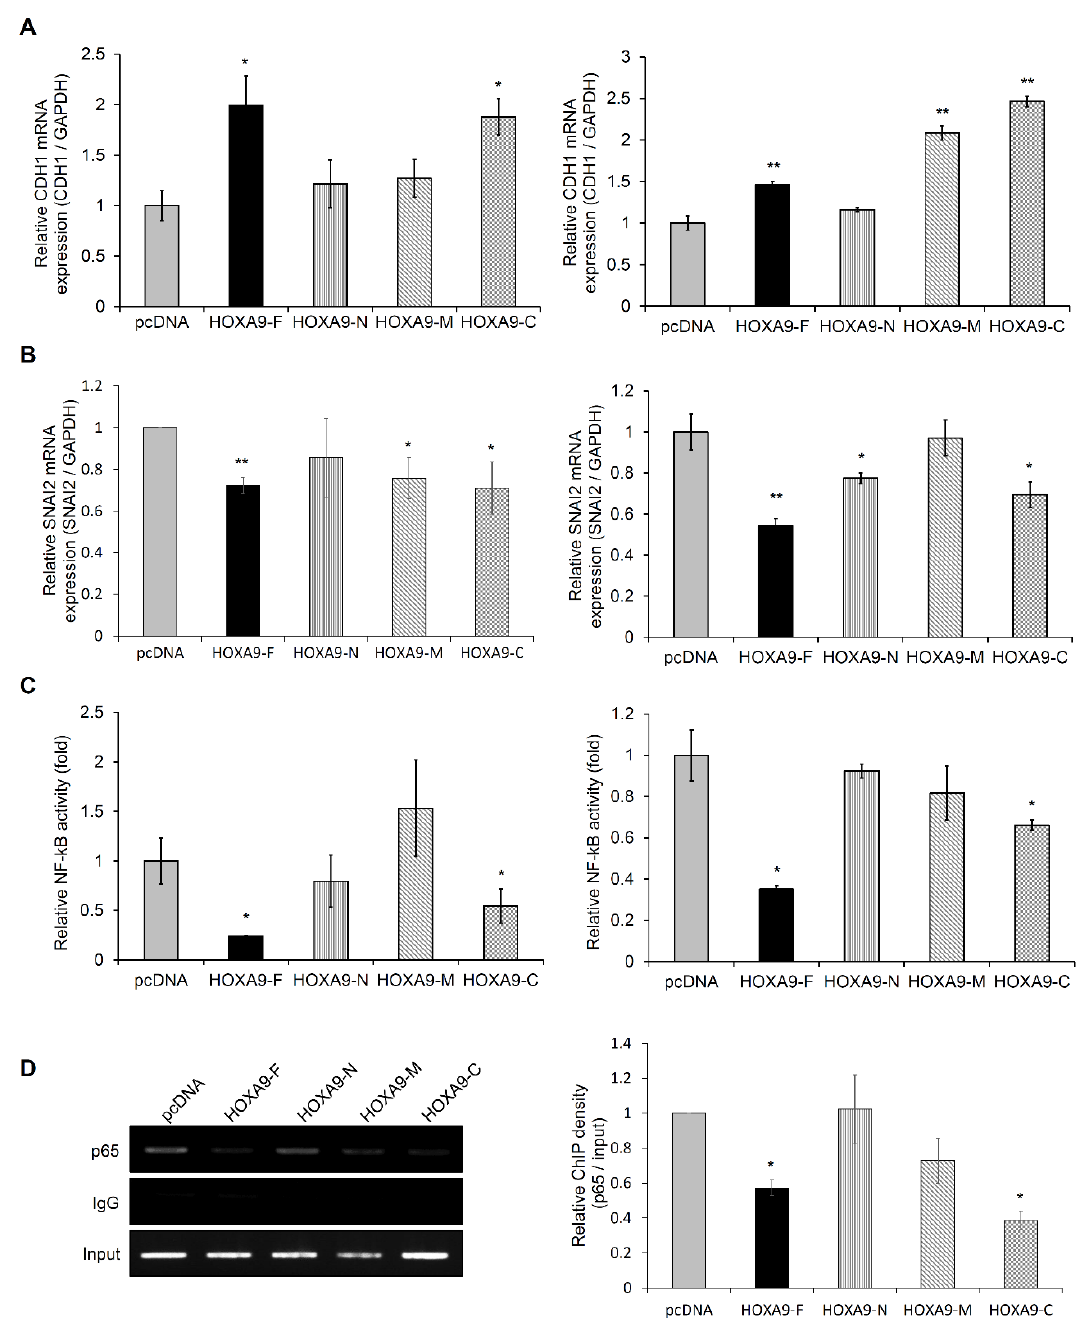
Figure 2. C-terminal fragment of HOXA9 regulates the expression of Epithelial-to-Mesenchymal Transition (EMT)-related genes. ( A ) The e ff ect of HOXA9 full-length or partial fragments on change of CDH1 mRNA expression in A549 (left) or NCI-H1299 (right) cells. The expression of CDH1 was analyzed by qRT-PCR. ( B ) The e ff ect of HOXA9 full-length or partial fragments on SNAI2 mRNA expression in A549 (left) or NCI-H1299 (right) cells. ( C ) The NF-kB activity in HOXA9 full-length or partial fragments transfected A549 (left) or NCI-H1299 (right) cells. The activity was measured by luciferase-based reporter assays. ( D ) Identification of NF-kB binding on the promoter region of SNAI2 by Chromatin Immunoprecipitation (ChIP) method in HOXA9 full-length or partial fragments transfected A549 cells. All data represent the mean ± SD from three independent experiments. * p < 0.05; ** p <